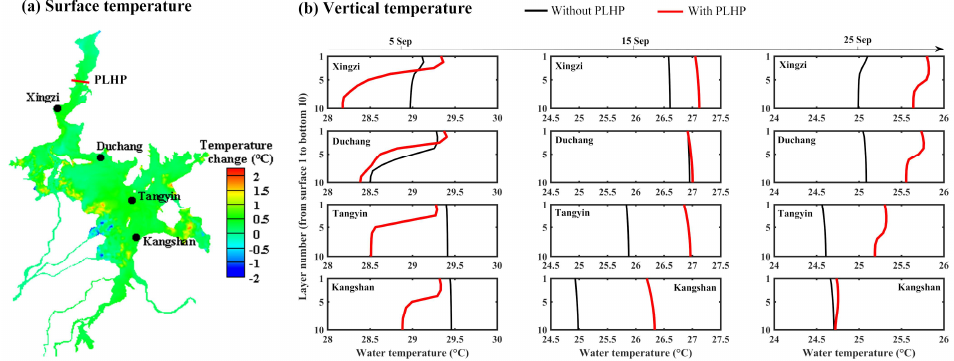
Figure 10. Influence of the PLHP on ( a ) water surface temperature and ( b ) vertical temperature within Poyang Lake. Positive changes in ( a ) indicate that the water temperature in the scenario with PLHP is higher than the natural condition.